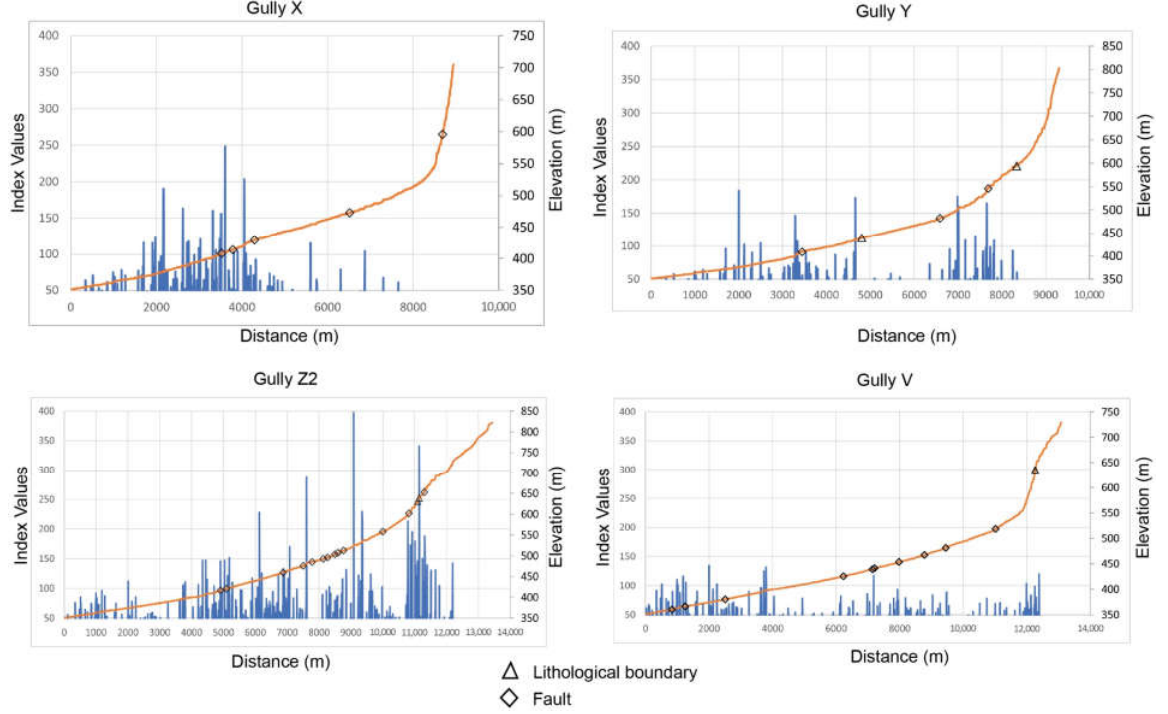
Figure 13. SLk indexes shown in longitudinal profiles for four gullies in the Geren catchment. See Figure 5 for selected gullies.